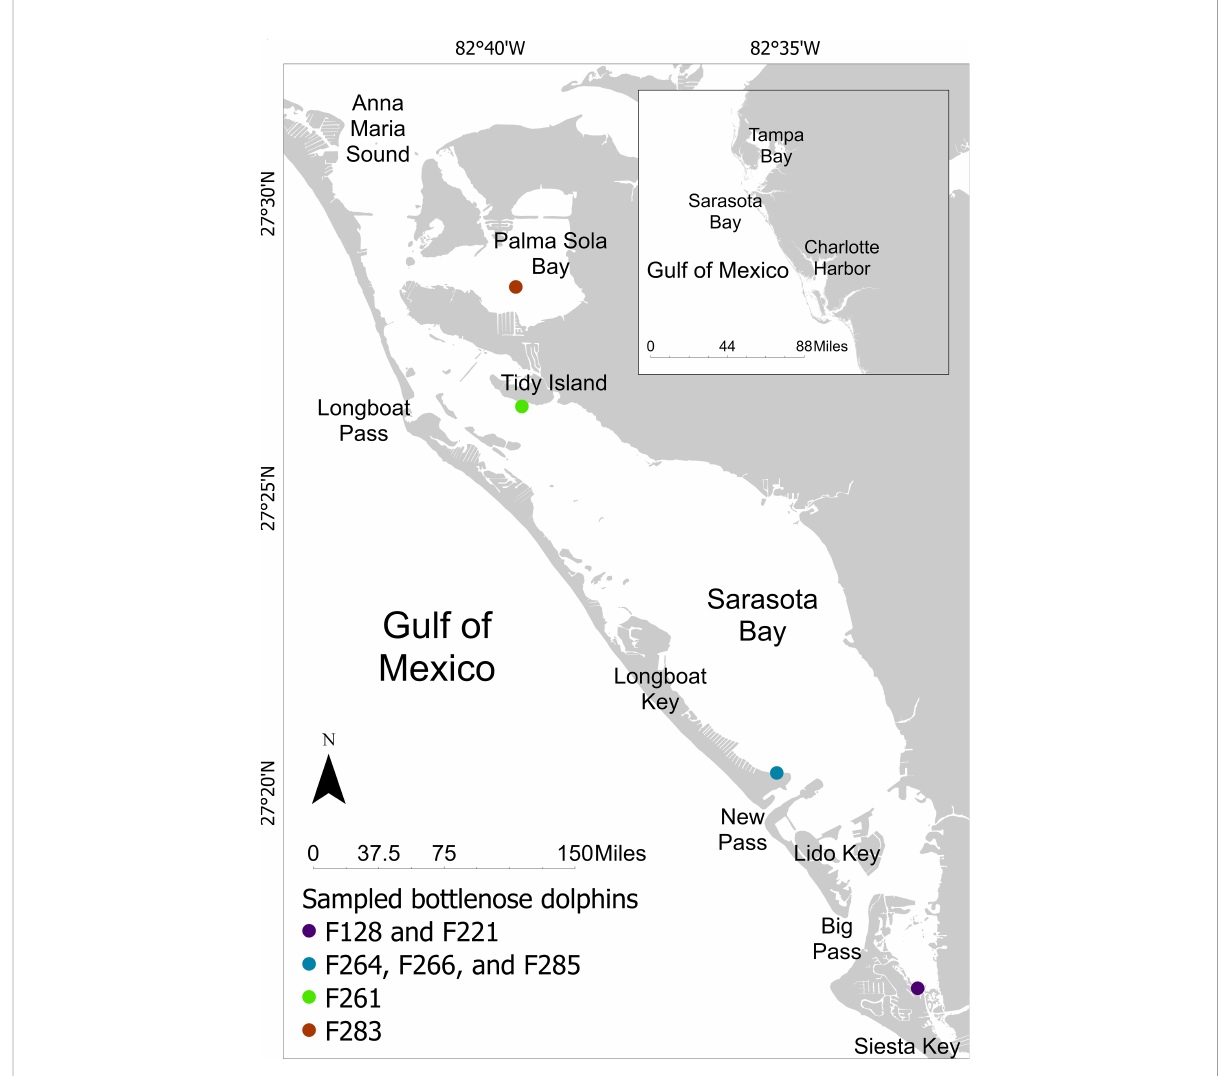
FIGURE 1 Locations of sampling sites for Bottlenose Dolphins Sampled during 2019 Catch-and-Release Health Assessments in Sarasota Bay,